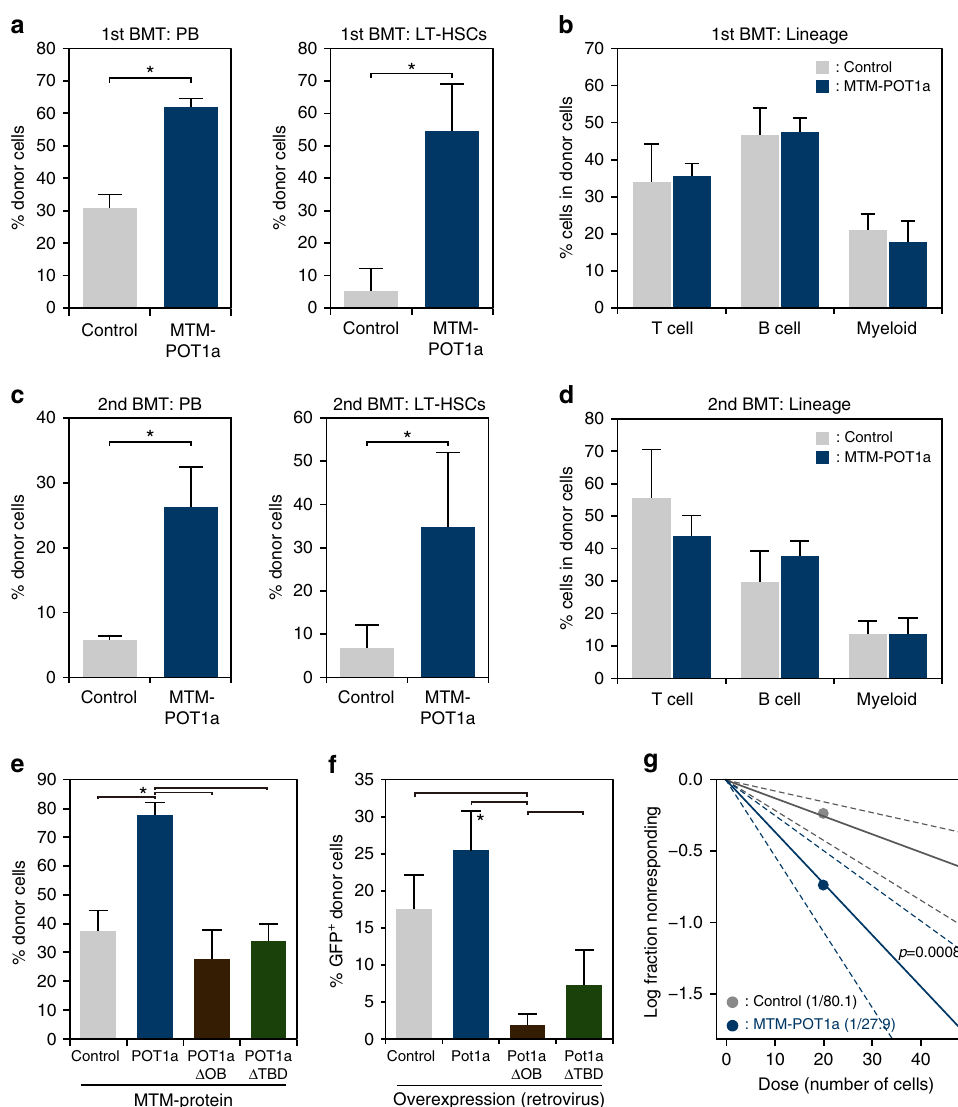
Fig. 7 MTM-POT1a maintains self-renewal activity of HSCs. a Results of primary BMT. Percentage of donor-derived (Ly5.1 + ) cells in PB and LT-HSC fractions 4 months after BMT. b Frequency of donor cells in T, B, and myeloid cell fractions in PB 4 months post BMT. Data are expressed as the mean ± SD ( n = 5 group – 1 , * p < 0.01, ** p < 0.05 by t -test). Representative data from four independent experiments are shown. c Results of secondary BMT. Percentage of donor-derived (Ly5.1 + ) cells in PB and LT-HSC fractions 4 months post secondary BMT. d Frequency of donor cells in T, B, and myeloid cell fractions in PB 4 months post secondary BMT. Data are expressed as the mean ± SD ( n = 5 per group, * p < 0.01 by t -test). Representative data from four independent experiments are shown. e Effect of mutant forms of POT1a in the regulation of LTR activity of HSCs. Percentage of donor-derived (Ly5.1 + ) cells in PB 4 months after BMT is shown. Data are expressed as the mean ± SD ( n = 5 group – 1 , * p < 0.01 by Tukey ’ s test). Representative data from two independent experiments are shown. f Effect of the overexpression of mutant forms of Pot1a on the maintenance of LTR activity of HSCs. Percentages of GFP + donor-derived cells in PB 5 months after BMT are shown. Data are expressed as the mean ± SD ( n = 5 per group, * p < 0.01 by Tukey ’ s test). Representative data from two independent experiments are shown. g Result of limiting dilution competitive BMT. A log-fraction plot of the limiting dilution model is shown. The slope of the line is the log-active cell fraction. The dotted lines give 95% con fi dence intervals ( n = 24: control 20 cells, n = 21: control 50 cells, n = 23: MTM-POT1a 20 cells, n = 23: MTM-POT1a 50 cells). Competitive repopulation units are also